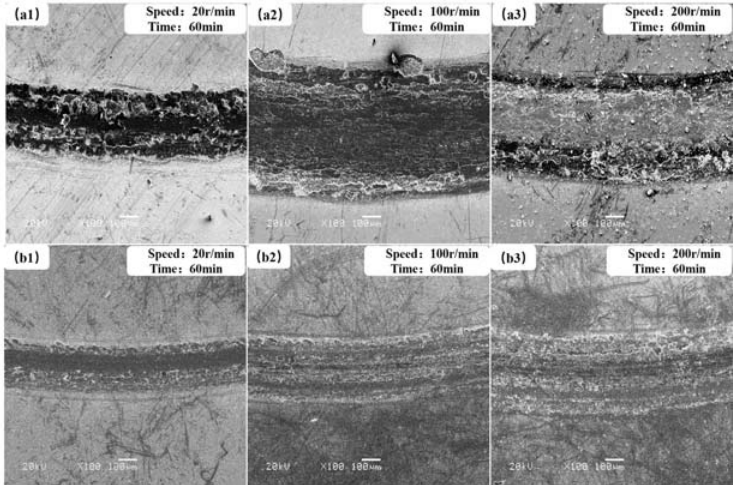
Figure 11. The morphologies of wear tracks for pure MoS 2 film ( a1 , a2 , a3 ) and MoS 2 –WS 2 composite film ( b1 , b2 , b3 ) under the vacuum and AO ‐ irradiation at different sliding speeds. Materials 2020 , 13 , x FOR PEER REVIEW